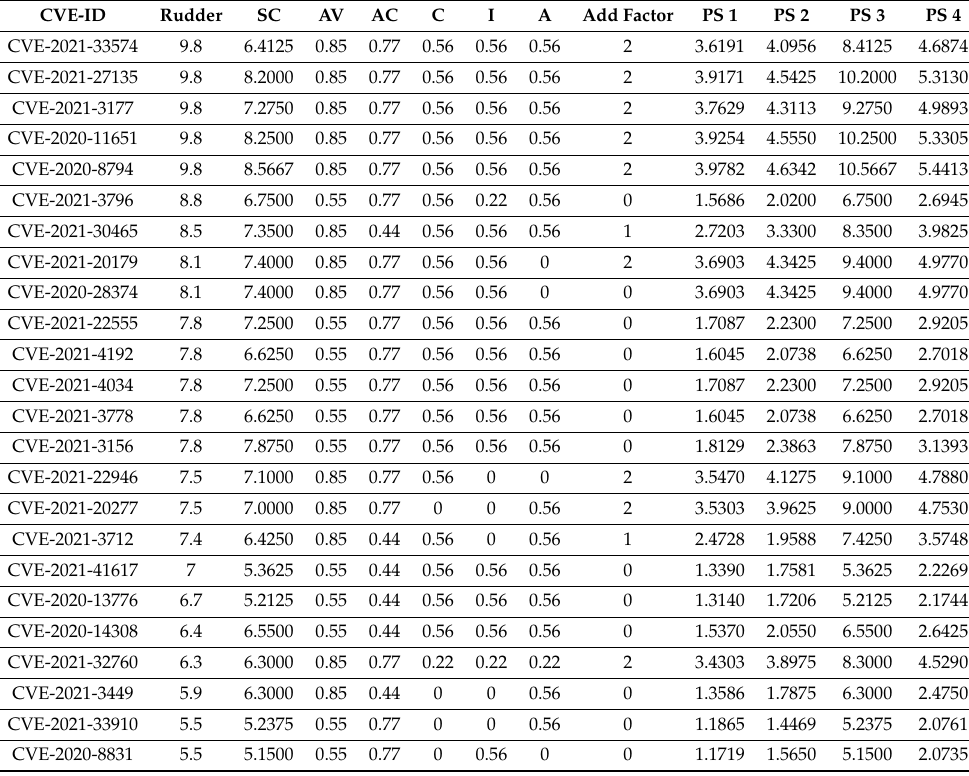
Table 7. Comparing the PS values in different cases with